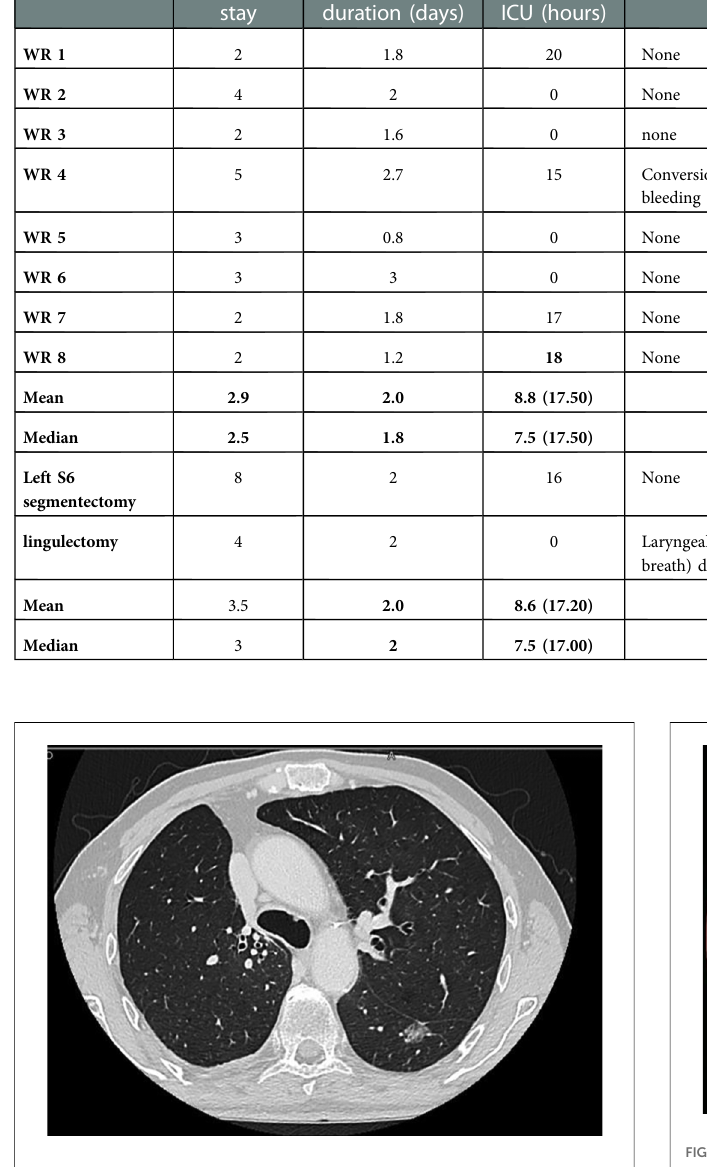
FIGURE 1 Pre-operative CT-scan of the left S6 segmentectomy showing the lesion.